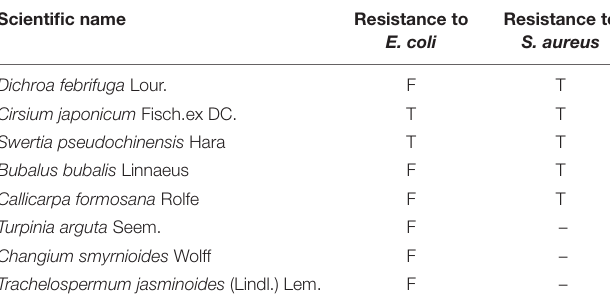
TABLE 2 | Prediction results of TCMs antibacterial activity.